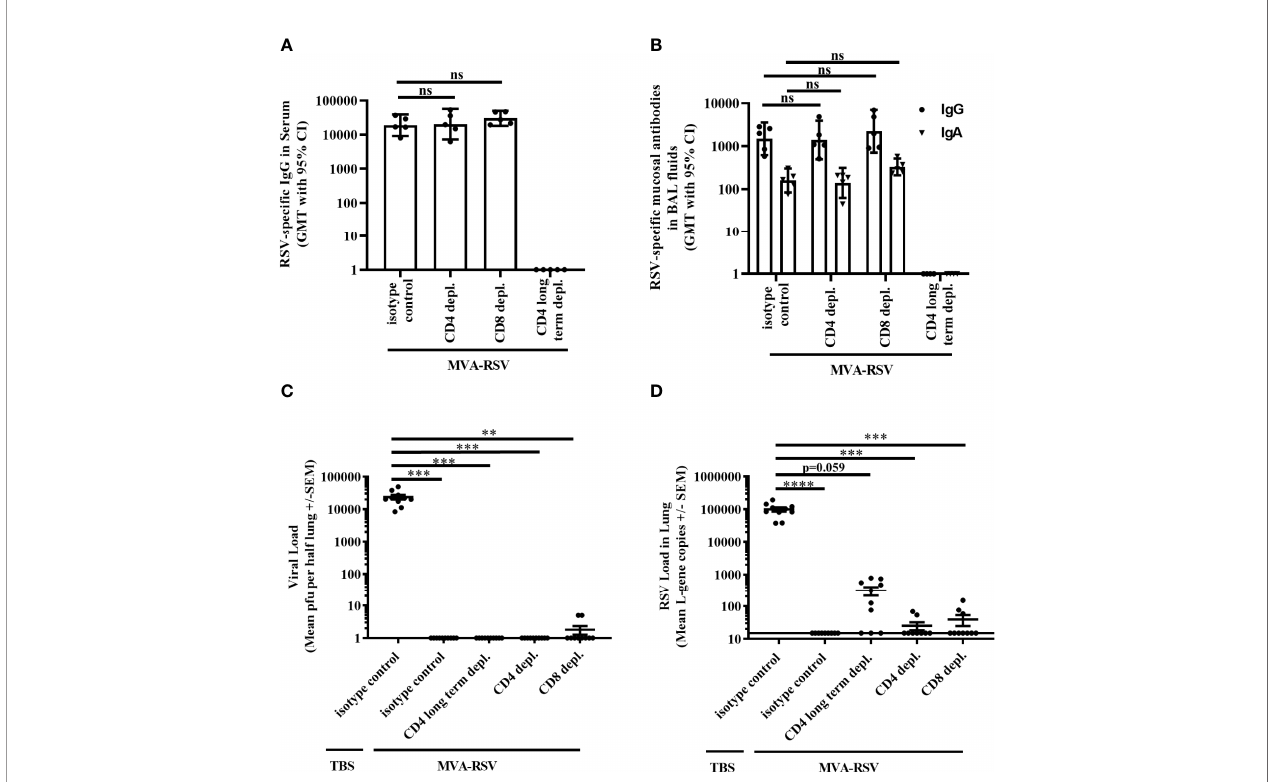
FIGURE 1 | Effect of T-cell depletion on ef fi cacy. BALB/c mice ( n = 5) either were vaccinated (IN) twice 3 weeks apart with 1 × 10 8 TCID 50 MVA-RSV or received TBS. RSV challenge (IN, 10 6 pfu) was performed 2 weeks after the last vaccination. One day prior and 1 day after RSV challenge, mice were either treated (IP) with an anti-CD4 (CD4 depl.) or anti-CD8 (CD8 depl.) or an isotype-matched control antibody (isotype control). For long-term depletion of CD4 T cells, injection with the anti-CD4 antibody was performed 2 days before prime vaccination and thereafter twice a week. (A) RSV-speci fi c IgG in serum was measured on Day 33 (12 days post second vaccination) by ELISA. Titers were comparable between vaccinated mice treated with the isotype control antibody and anti-CD4 or anti-CD8 antibody ( p = 0.9965 for CD4-depleted mice and p = 0.5426 for CD8- depleted mice; Tukey test). (B) RSV-speci fi c mucosal IgA and IgG in BAL fl uids were measured on Day 39 (4 days post challenge) by ELISA. Mice treated with anti-CD4 or anti- CD8 antibody had comparable RSV-speci fi c mucosal IgA ( p = 0.9717 for CD4-depleted mice and p = 0.1087 for CD8-depleted mice, Tukey test) as well as mucosal IgG ( p = 0.9991 for CD4-depleted mice and p = 0.8205 for CD8-depleted mice, Tukey test) to vaccinated mice treated with the isotype control antibody. No antibodies could be measured in the CD4 long-term depleted group. For both panels the geometric mean titers (GMT) with 95% con fi dence interval (CI) are shown. Representative data of one out of two mouse studies are shown. ns: not statistically signi fi cant. Four days post challenge mice were sacri fi ced and the viral load in lung was measured by (C) plaque assay. Mean pfu per half lung ± SEM is shown. (D) Viral load detected by RT-qPCR. Mean L-gene copies ± SEM is shown; the black line indicates the lower limit of detection (LLOD = 15 gcs). Plaque assay data showed signi fi cant differences between TBS-treated control mice and all other groups (*** p < 0.0005, ** p < 0.005 Dunn ’ s method). RT-qPCR data showed signi fi cant differences between TBS-treated control mice and vaccinated control mice, CD4 depl. mice, and CD8 depl. mice (**** p < 0.00005, *** p < 0.0005 Dunn ’ s method). Pooled data of two separately performed mouse studies are shown ( n = 9 or